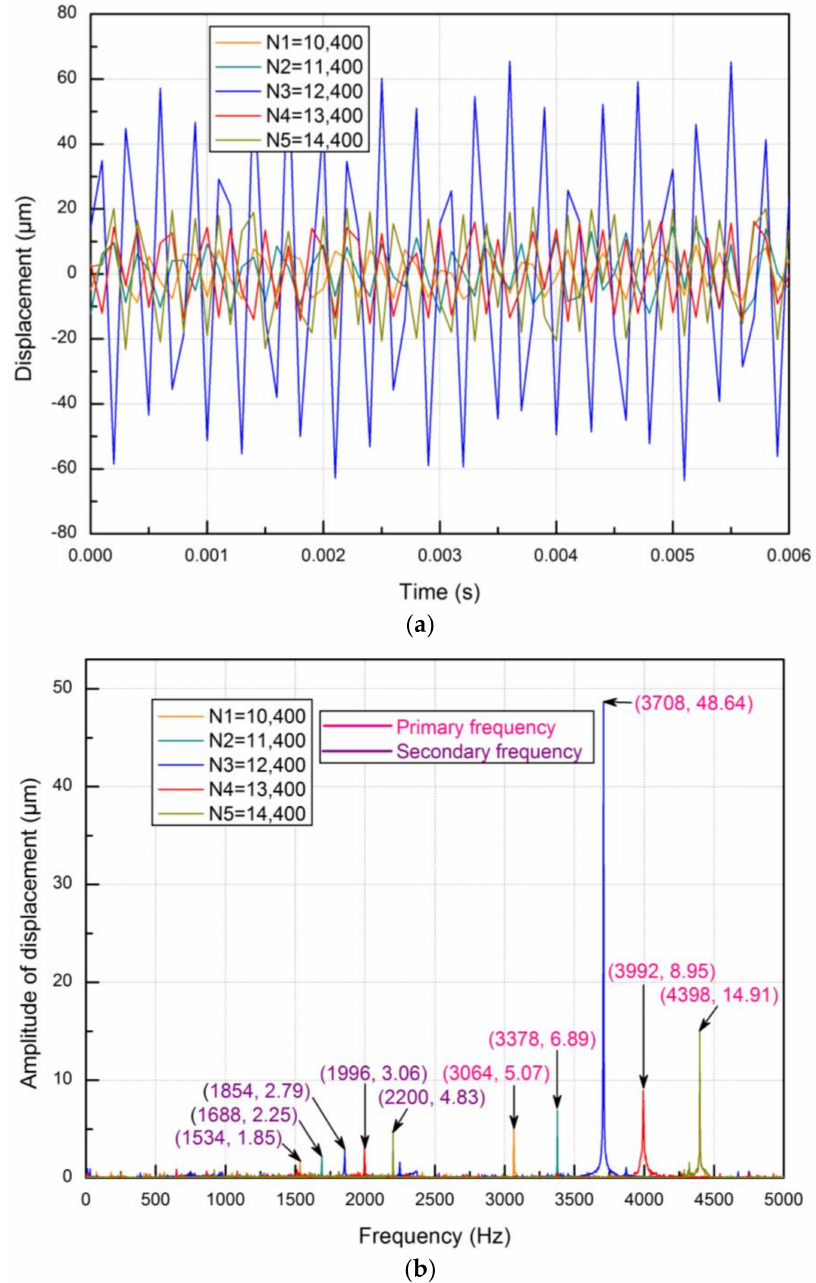
Figure 10. Characteristics of the armature vibration for the Type A flapper-armature assembly: ( a ) in the time domain; ( b ) in the frequency